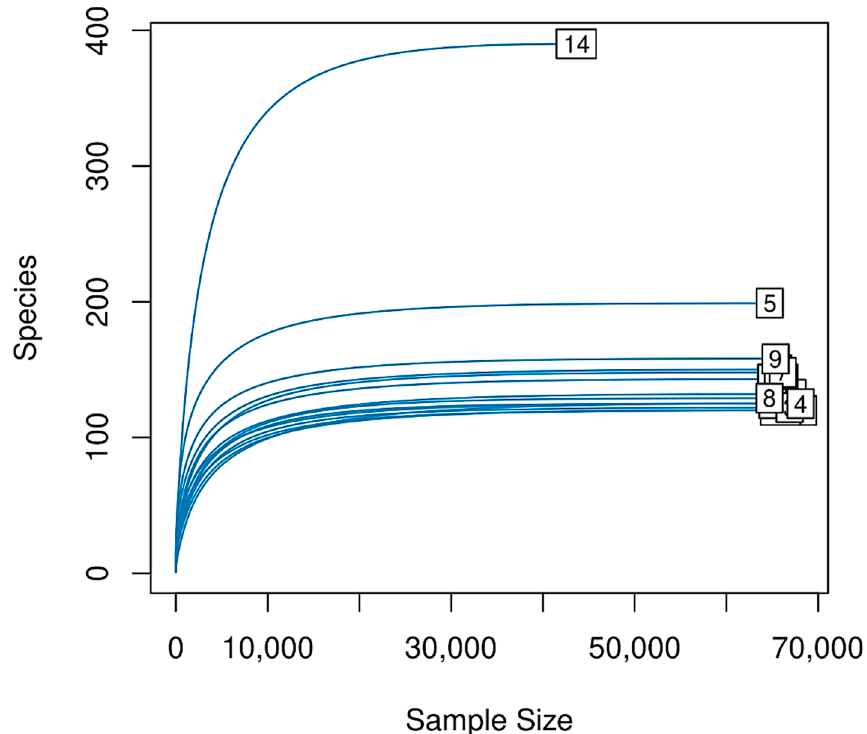
Figure 1. Rarefaction curves. Each sample was analyzed to determine the number of unique ASVs ( y -axis) as a function of the sample size ( x -axis). Rarefaction curves show saturation of the identified ASVs as the deep increased.